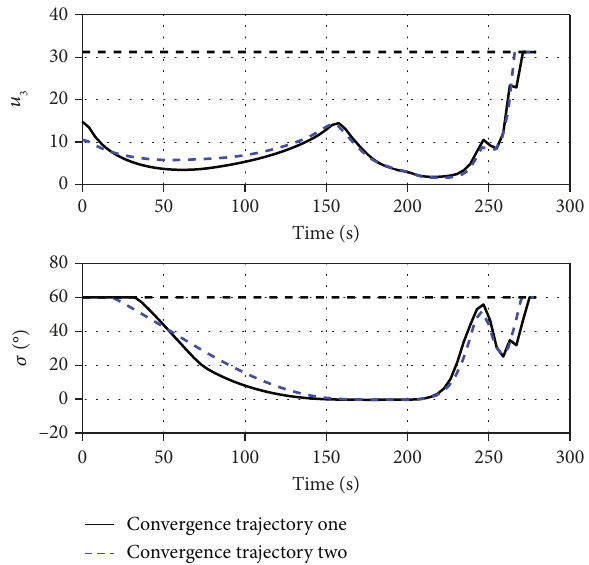
Figure 14: Control variables under di ff erent initial trajectories.